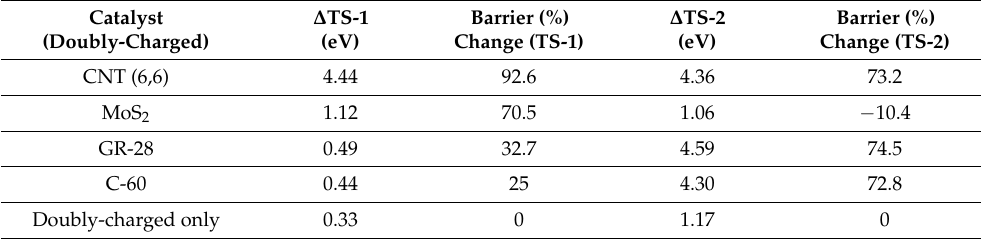
Table 1. Direct comparison of the calculated relative transition state barrier differential heights from initial states ( ∆ TS = TS-initial state) for steps 1 and 2 of the oxidation–reduction reaction to atomic sulfur are represented by ∆ TS-1 and ∆ TS-2 in electron-volts (eV). Armchair (6,6), carbon nanotube (CNT (6.6)), molybdenum disulfide (MoS 2 ), graphene flake containing 28 atoms (GR-28), and fullerene (C-60) are the doubly-charged